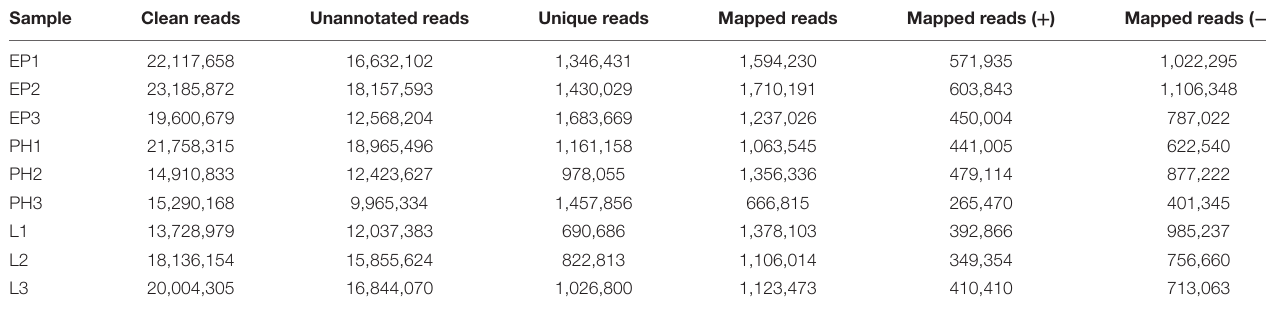
TABLE 2 | The output of